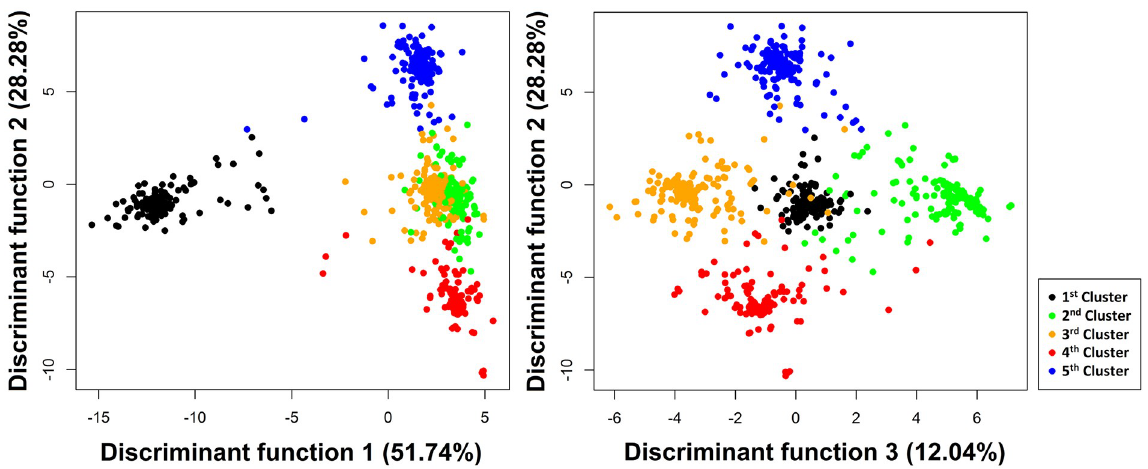
Fig 5. Distribution of the five clusters identified by discriminant analysis of principal components of single nucleotide polymorphism markers (SNPs).